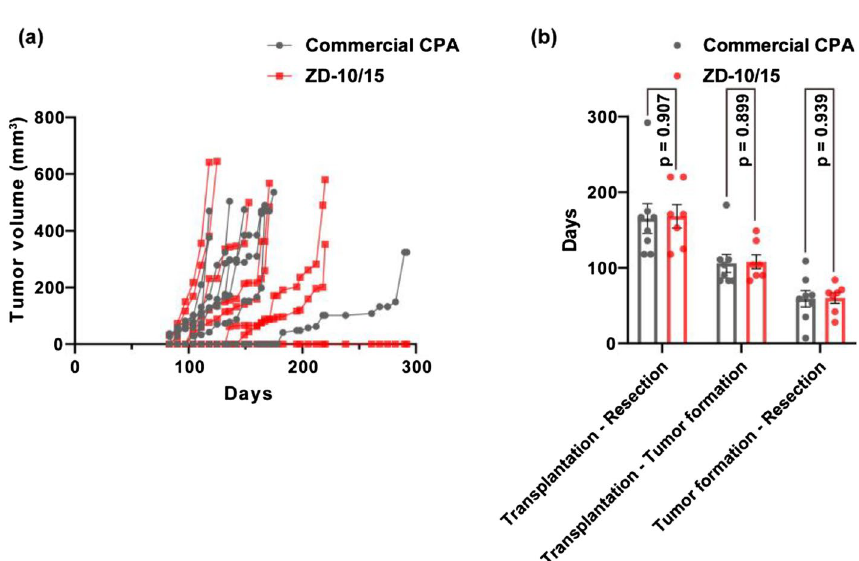
Figure 5. Tumor growth and its speeds of cryopreserved patient-derived xenografts using commercial CPA and ZD-10/15. ( a ) Tumor formation and growth of PDXs after cryopreservation with the commercial CPA or ZD-10/15. PDXs were resected at the final marked days. ( b ) The number of elapsed days from transplantation to resection (resection was carried out after growing by the long diameter of approximately 10 mm),